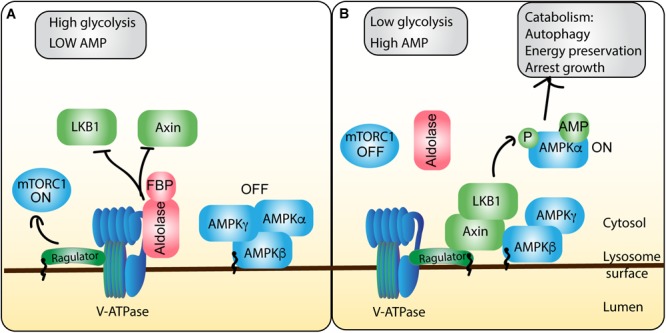
AMPK integration of energy stress shapes mTORC1 activity at the lysosome. ATP and glycolytic activity are sensed and integrated by the AMPK regulatory machinery on the lysosome, allowing for cross-talk to the mTORC1 pathway. (A) In conditions of energy sufficiency, there is high ATP levels relative to AMP, which permits ATP to compete with AMP for binding to AMPK, maintaining the inactive heterotrimeric AMPK complex. Moreover, high glycolytic activity produces abundant fructose-1,6-bisphosphate (FBP), which forms a complex with aldolase. The aldolase-FBP complex interacts with the V-ATPase to thwart recruitment of LKB1 and AXIN to the lysosome and protect V-ATPase-Ragulator association. Collectively, these events abate AMPK and stimulate mTORC1 activity. (B) During conditions of energy insufficiency, AMP concentrations rise, increasing the frequency of AMP-bound AMPK, priming AMPK for activation. Moreover, decreased glycolysis activity drops the levels of FBP and FBP-aldolase. This permits the formation of a complex between Ragulator, V-ATPase, Axin and LKB. Collectively, this allows LKB1 to phosphorylate and release the catalytic α subunit, allowing it to promote catabolic cellular programs, while preventing Ragulator from promoting mTORC1 function.